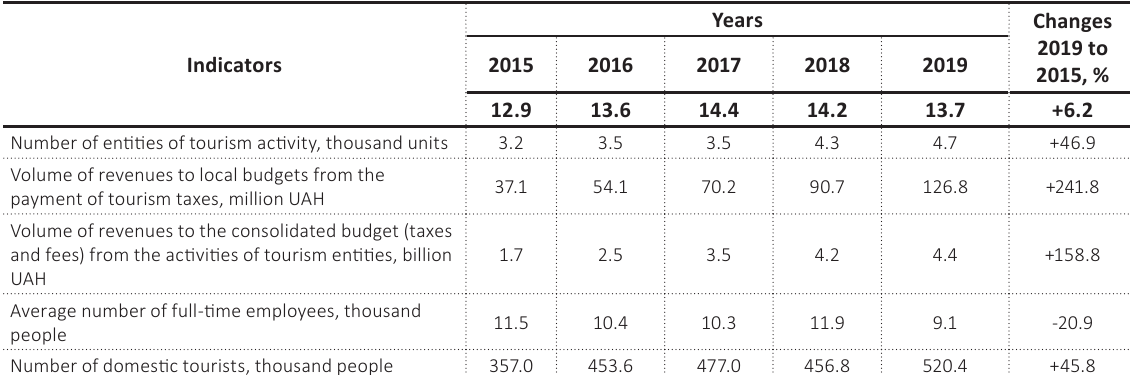
Source: State Statistics Service of Ukraine